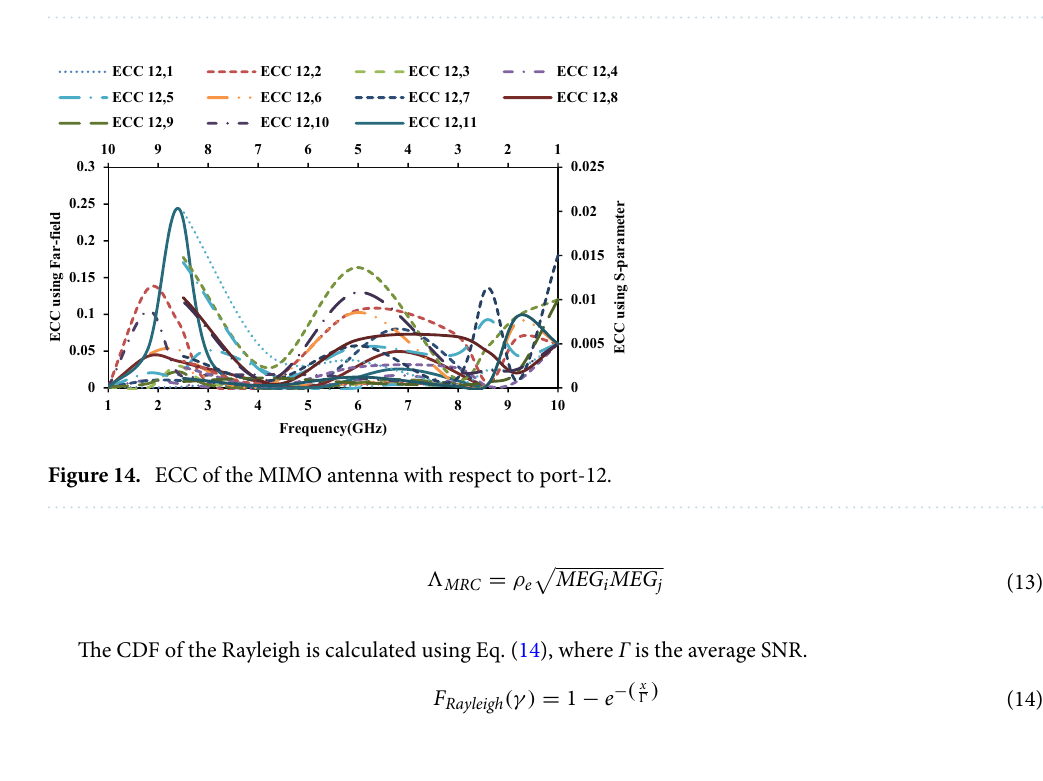
Figure 13. ECC of the MIMO antenna with respect to port-1.